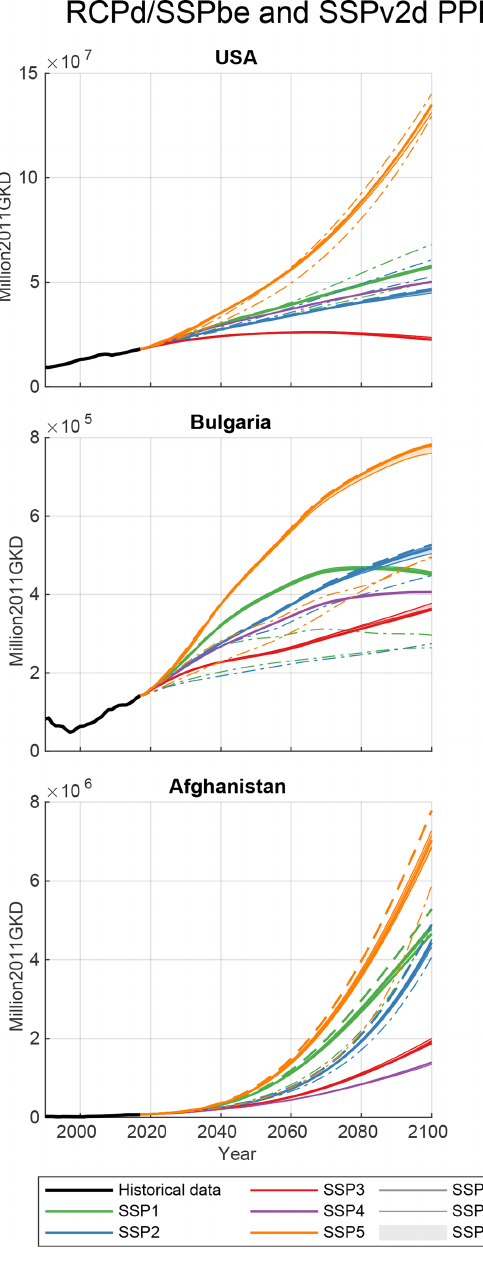
Figure 6. GDP projections for all SSPs (basic elements and downscaled SSPv2). All scenarios harmonized to historical values. Countries from the regions of the OECD and Asia. The SSP-basic-elements data from PIK and IIASA vary substantially from the OECD data, and the OECD-based SSPv2 data vary for some countries and SSPs. GDP growth varies substantially between